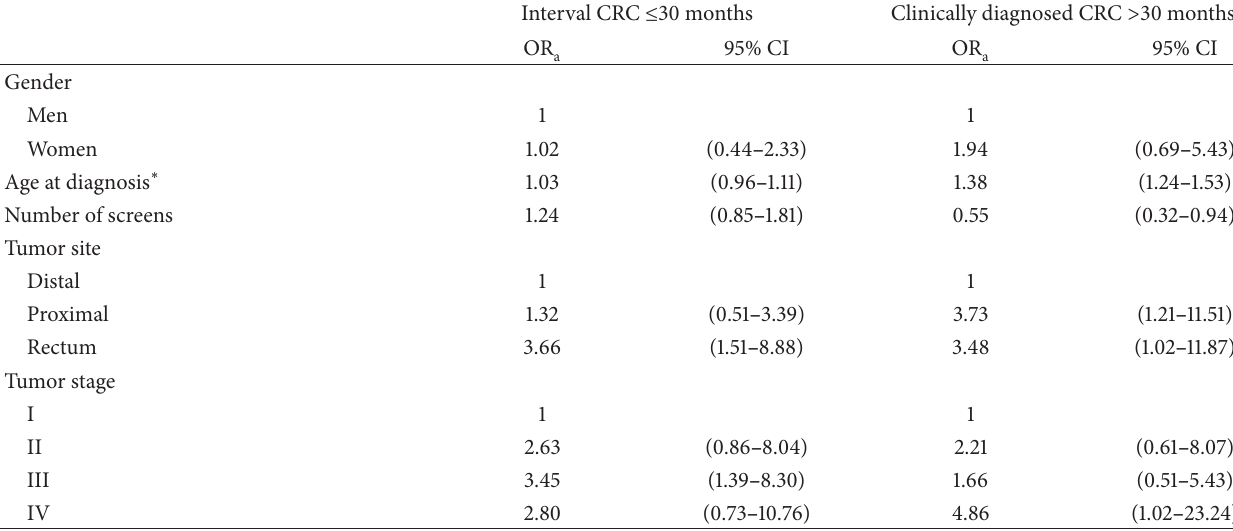
Table 4: Factors associated with clinically diagnosed CRC among individuals who ever participated in the screening program for CRC ( ≤ 30 months versus > 30 months since their last screening).